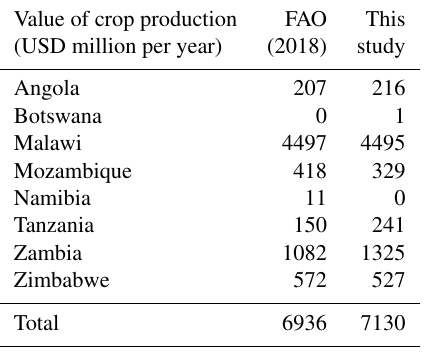
Table 8. Hydropower production. Simulated hydropower produc- tion is compared to the results of the MSIOA study (World Bank, 2010). Firm power is calculated as the power production available 99% of the time (at the monthly scale) at a single